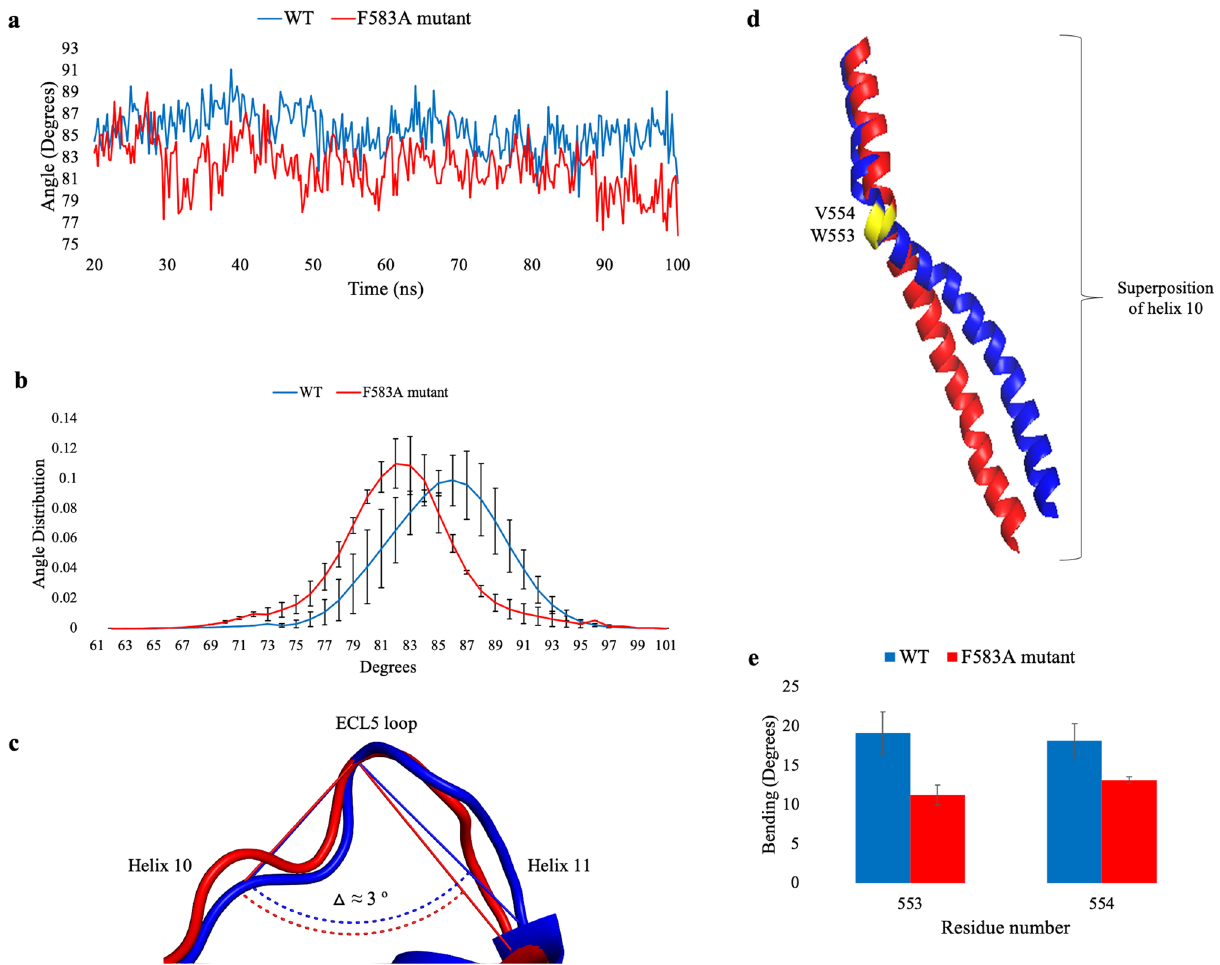
Figure 6. Measurements of the interhelical angle between helices 10–11 ( a–c ) and the bending of helix 10 in the WT (blue) and F583A mutant (red) ( d,e ). (a) The interhelical angle between helices 10–11 (degrees) as a function of simulation time (ns) showing a wider dynamic angle in the WT protein in comparison with the mutant. The averages of the three WT and the three F583A mutant simulations are presented. (b) Distributions of the average interhelical angle’s values (degrees) of the three WT and three F583A mutants are presented. The F583A mutant’s distribution is narrower and shifts to the left compared to the WT’s distribution, showing smaller angles than in the WT. The averages of the three WT and the three F583A mutant distributions are presented. (c) Representative cartoon superposition of the opening angle between helices 10–11 for the WT and the F583A mutant, calculated by defining vectors as the angle axes. The delta ( △ ≈ 3 º) represents the difference in the interhelical angle. (d) A representative cartoon comparison presentation of the bending of helix 10 in the WT and F583A mutant. Residues W553–V554 are colored in yellow, presenting the starting point of helix